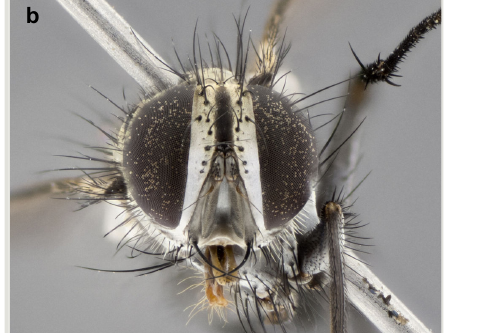
Figure 4. General morphology of Calolydella argentea sp. n. ; a–c : female holotype, voucher n.